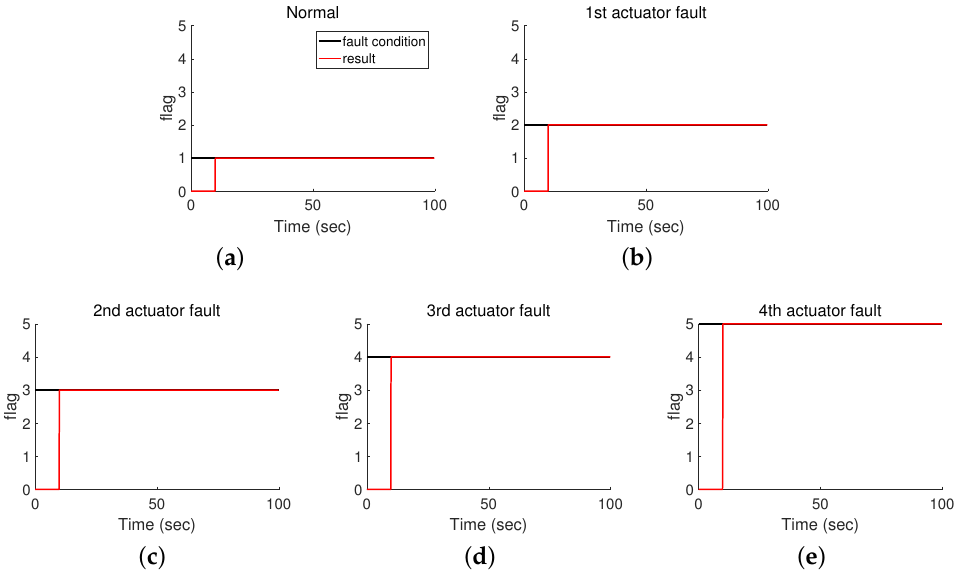
Figure 10. Online fault detection result in clockwise circular trajectory experiment with disturbance. ( a ) No fault. ( b ) First actuator fault. ( c ) Second actuator fault. ( d ) Third actuator fault. ( e ) Fourth actuator fault.